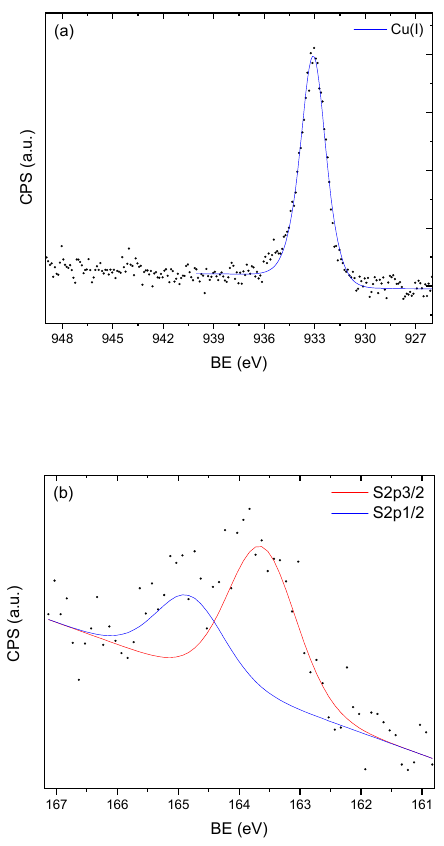
Figure 4. The ( a ) copper 2p 3/2 and ( b ) sulfur 2p 3/2,1/2 X-ray photoelectron spectra of porous silica/KL precipitated from the solution/Cu(II) sample after H 2 S adsorption.